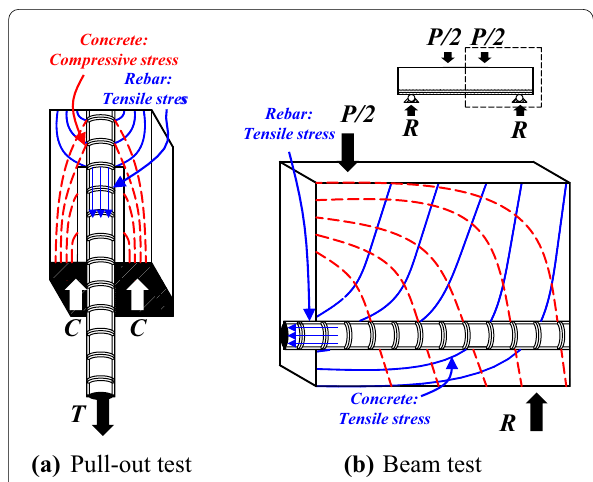
Fig. 1 Stress distribution in pull‑out and beam specimens (Tastani & Pantazopoulou, 2002).